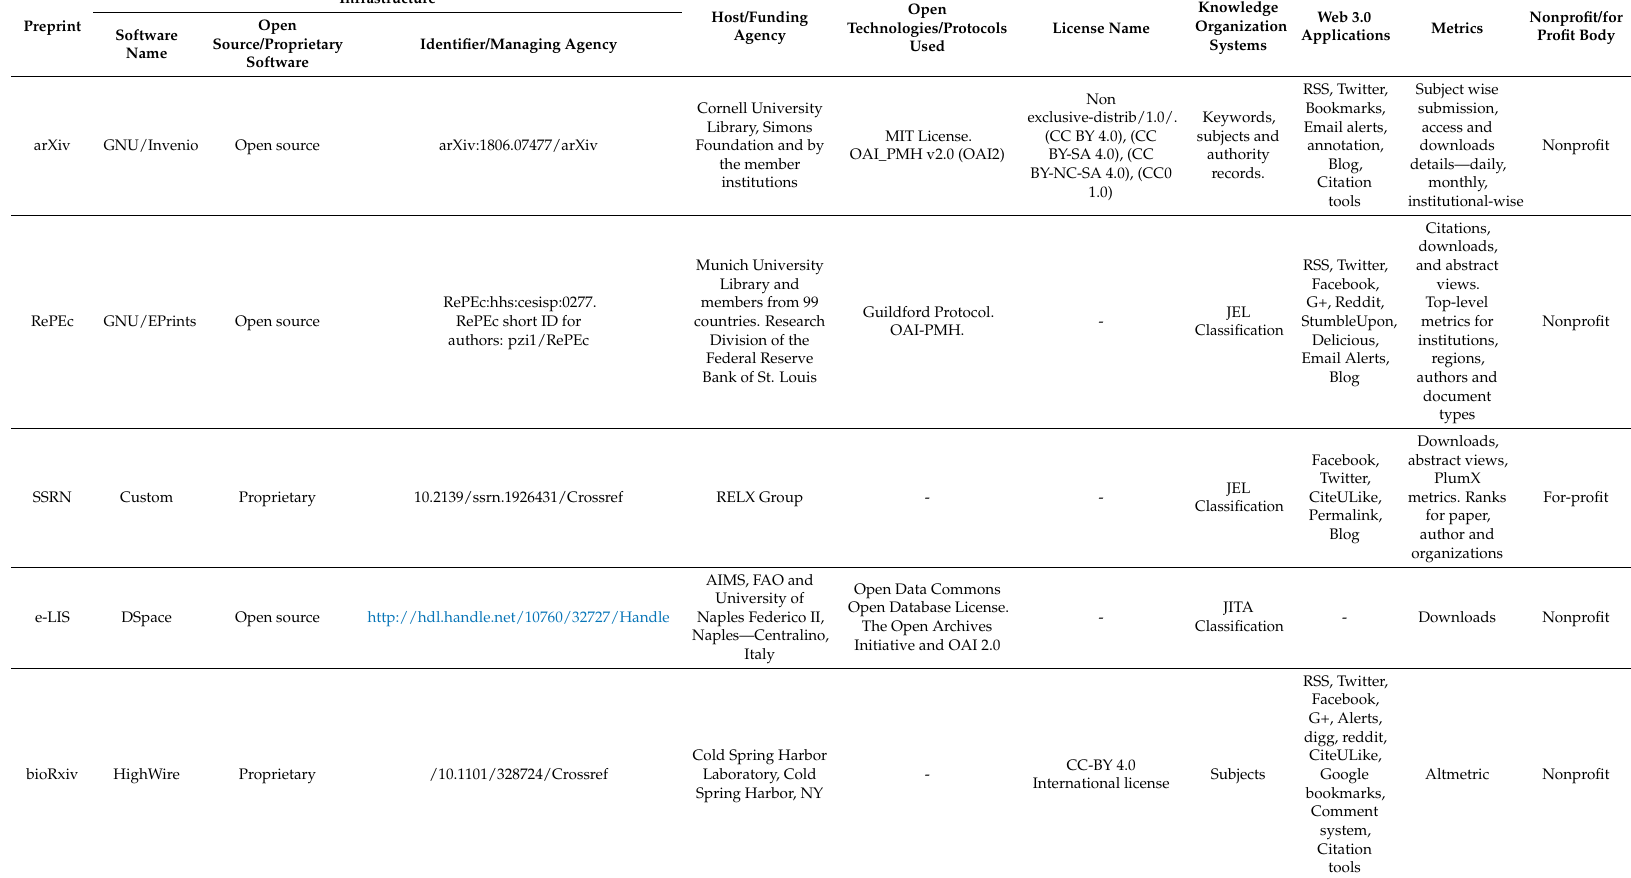
Table 2. Comparative features of preprint repositories 2